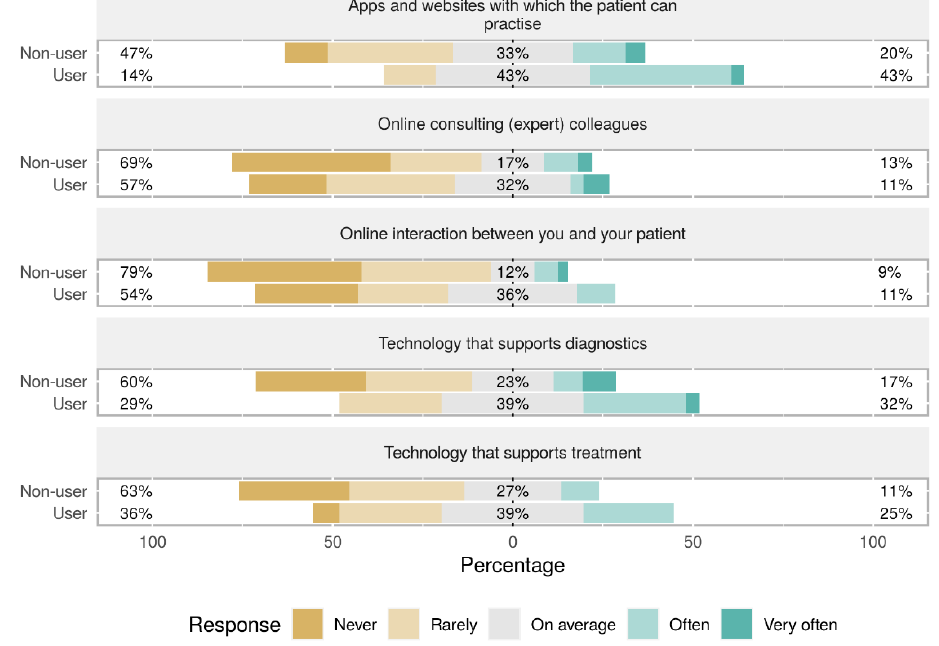
Figure 1. Other health technology used by participants, with differences between users and non-